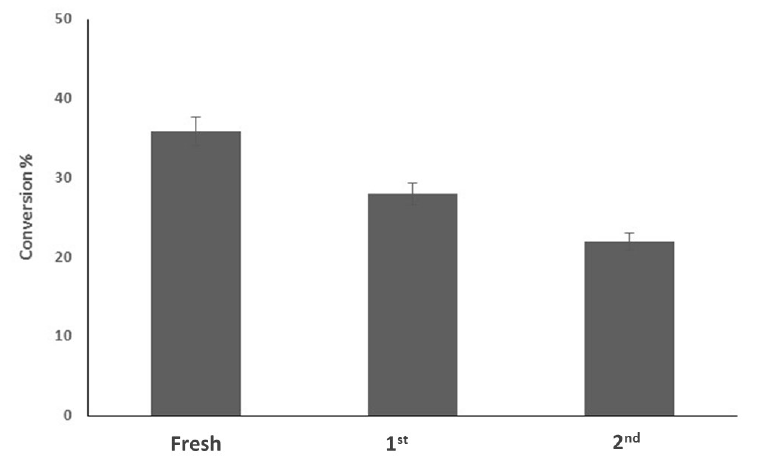
Figure 6. Conversion of benzyl alcohol during oxidation with reusability over Pd–Cu/TiO 2 . Reaction conditions: 0.02 g catalyst and 2 gm of benzyl alcohol conducted at 120 °C, O 2 (1 bar), stirred at 1000 rpm.